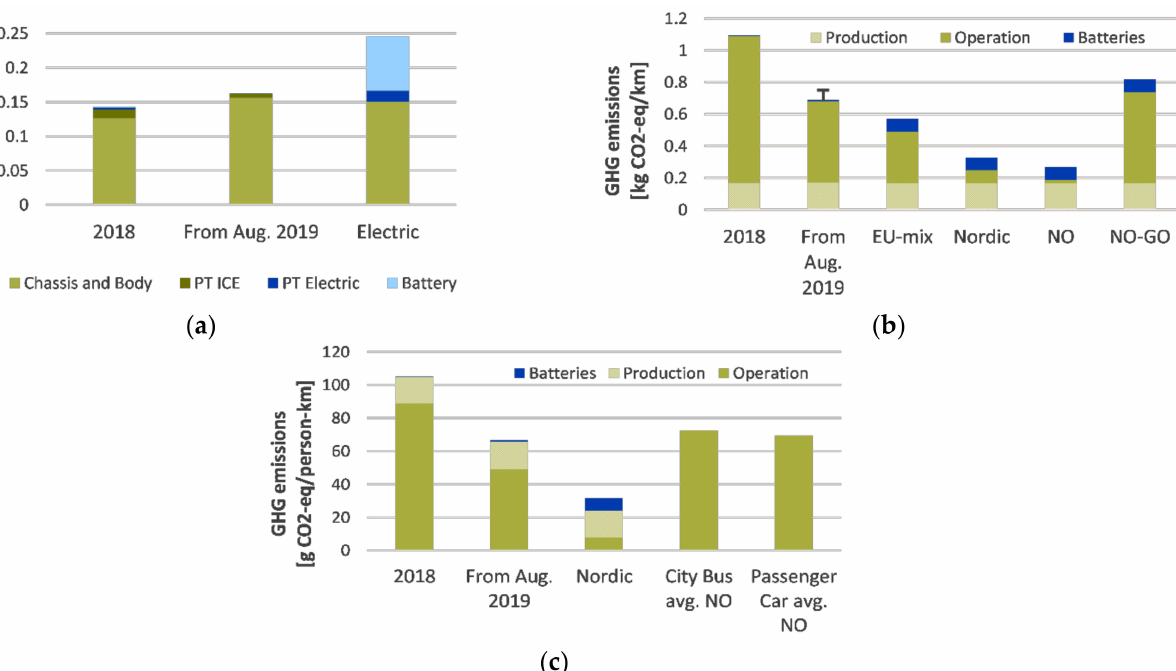
Figure 5. ( a ), embodied production emissions from the fleet scenarios; ( b ), carbon footprint from the bus fleet scenarios; and, ( c ), Carbon footprint of bus fleets compared to average city bus and passenger car in Norway. NO-GO represents charging with electricity in Norway without buying Guarantees of Origin (520 g CO 2 -eq/kWh). The error bar represents the range for electric buses from charging with a Norwegian el-mix as the lowest and NO-GO el-mix as the highest. PT, Powertrain; ICE, internal combustion